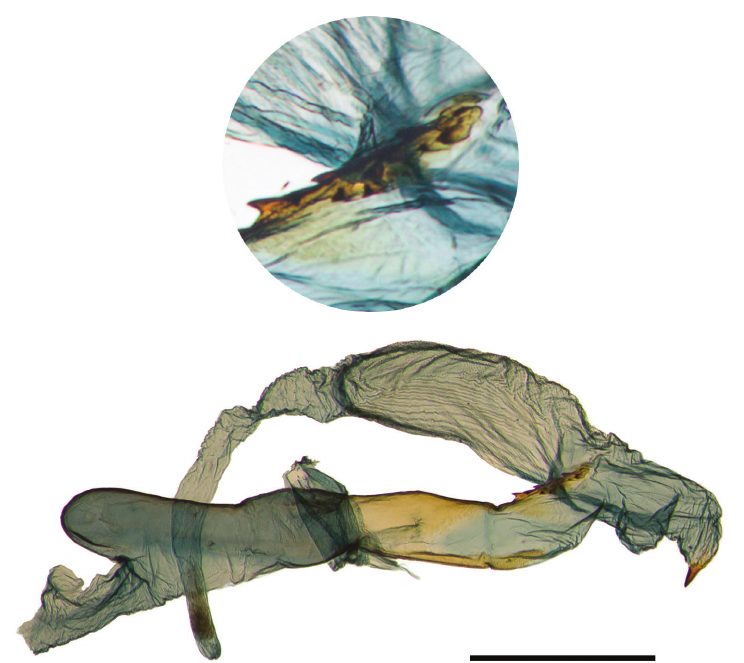
Figure 20. Everted vesica of A. nefascia , Yakima, WA. USNM dissection #s 148023, 148024. Scale bar: 1